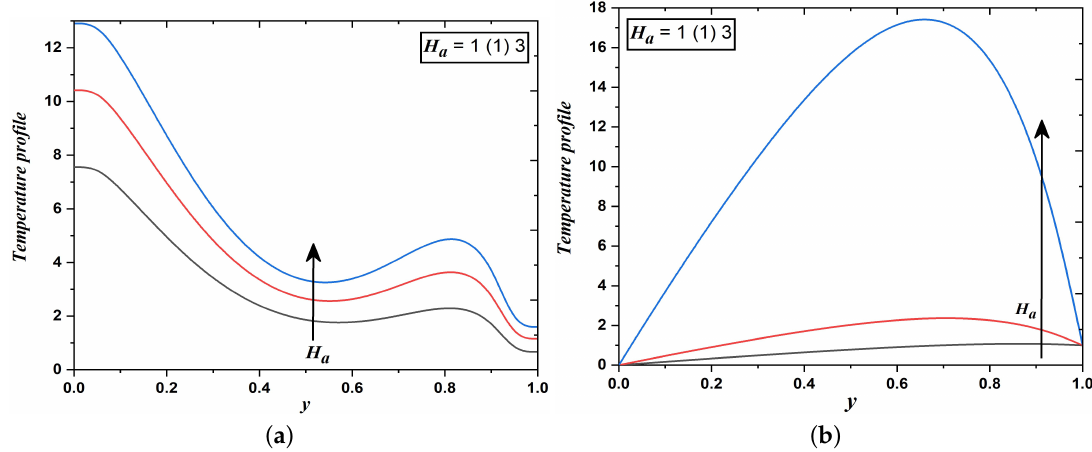
Figure 6. Temperature field when Hartmann number varies (Case 1 &